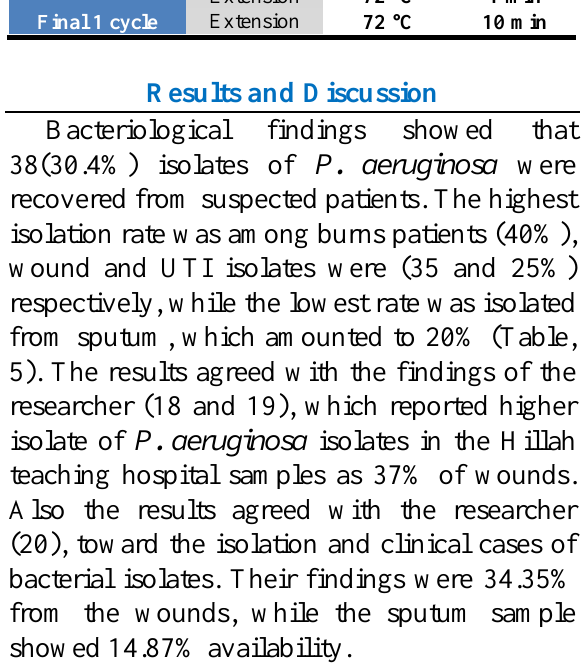
Table, 5: Distribution of P. aeruginosa isolates